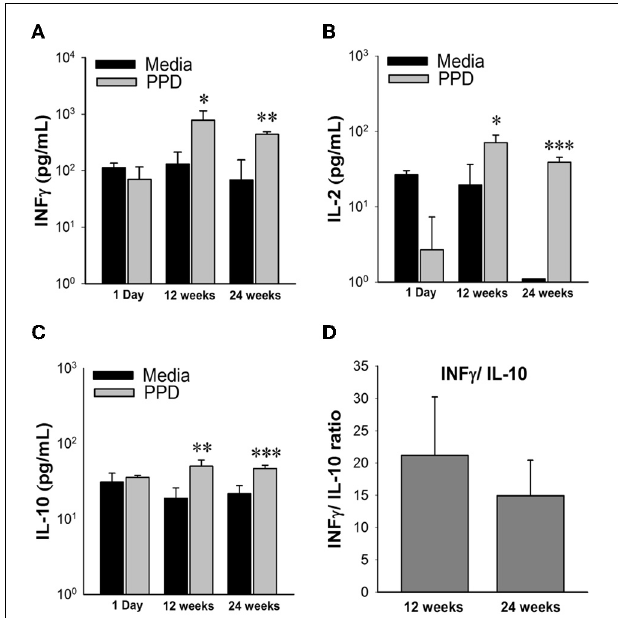
FIGURE 3 | Cytokine profiles of high dose M. avium subsp. paratuberculosis orally infected mice over 24 weeks post infection. Graphs ( A–C ) depict cytokine levels of mice orally infected with two consecutive doses of 10 9 CFU of M. avium subsp. paratuberculosis K10 over a 24 week period. At time of sacrifice, mouse spleens were collected and splenocytes were isolated and stimulated with Johnin Purified Protein Derivative (PPD) or media only for 48h. Supernatant was collected and used for cytokine quantification by luminex bead array. Black bars represent the mean levels of media only background levels with their standard deviation and gray bars represent the mean levels from stimulation with PPD with their standard deviation. Significant increases in PPD stimulated splenocytes were determined by comparison to media only levels. ( ∗ p < 0 . 05, ∗∗ p < 0 . 01, ∗∗∗ p < 0 . 001). To determine shifts in immune response from 12 to 24 weeks, levels of IFN γ were divided by IL-10 from individual mice (D) . The mean ratio and standard deviation for each time point is shown.